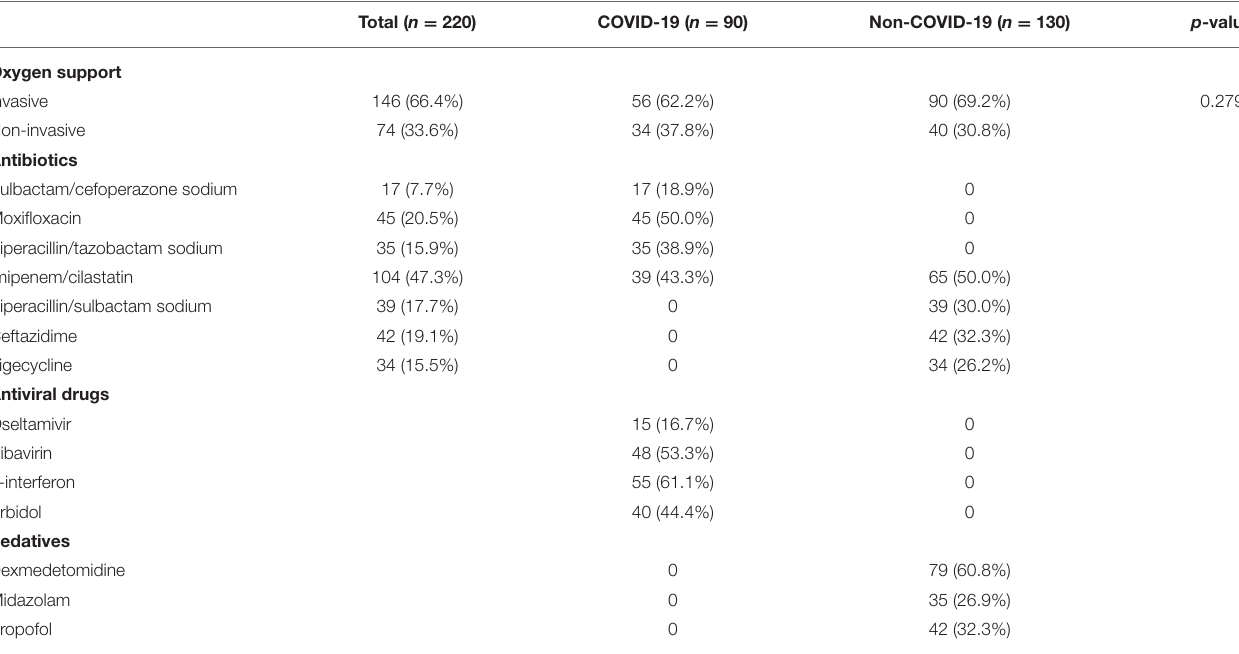
TABLE 6 | Treatment of ALI patients in the COVID-19 and non-COVID-19